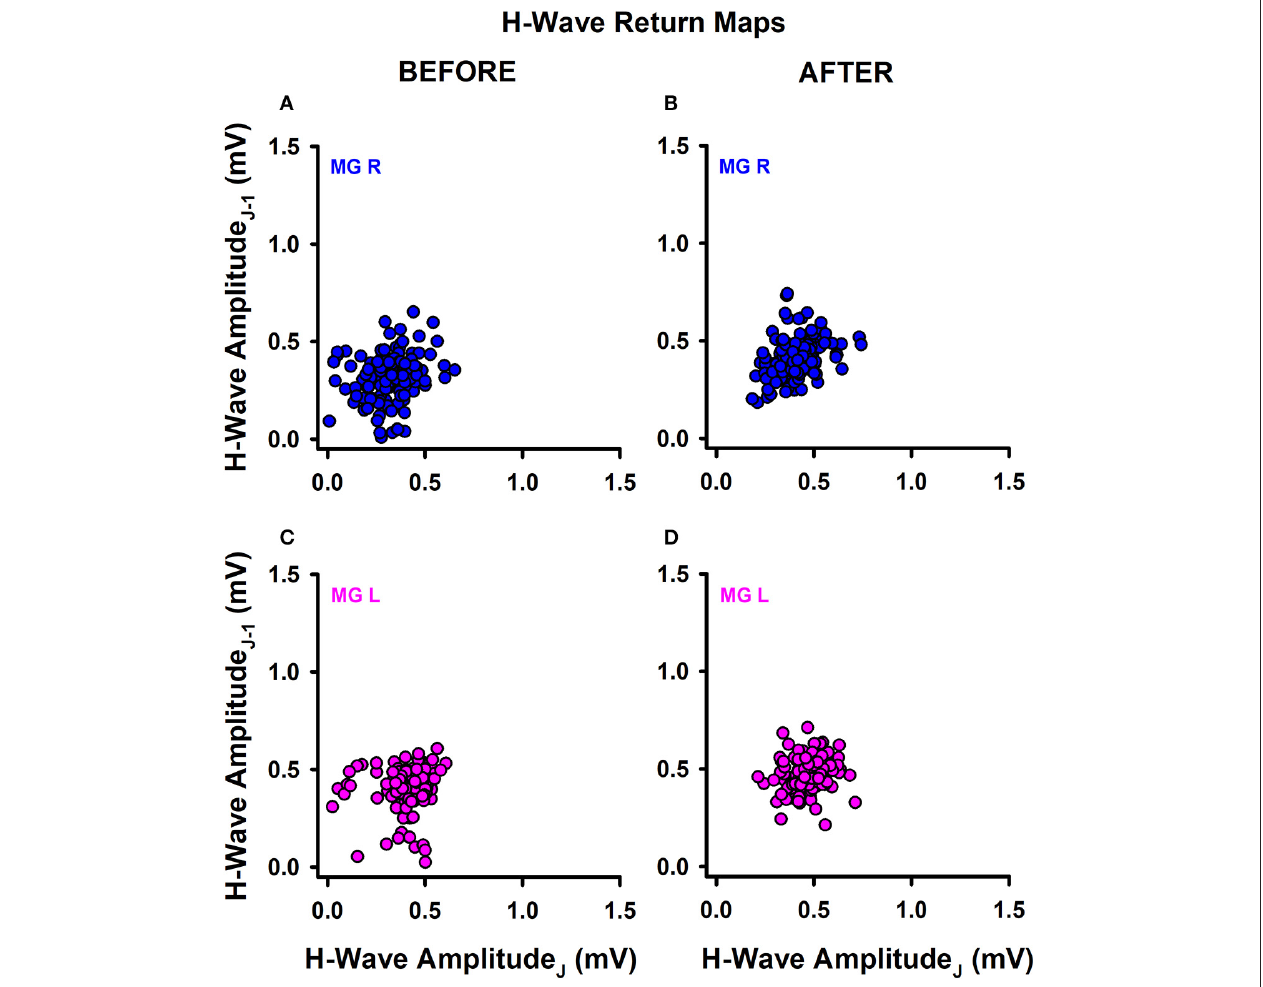
FIGURE 3 | Return maps obtained from successive H-waves. (A) MGR amplitude of H-waves before training. (B) MGR amplitude of H-waves after training. (C,D) The same as (A,B) but for the